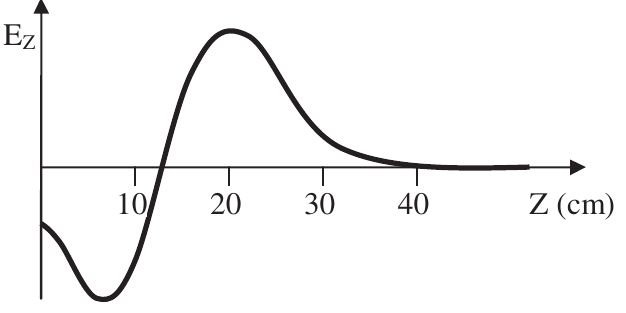
FIG. 14. Field strength on the axis of the rf gun.